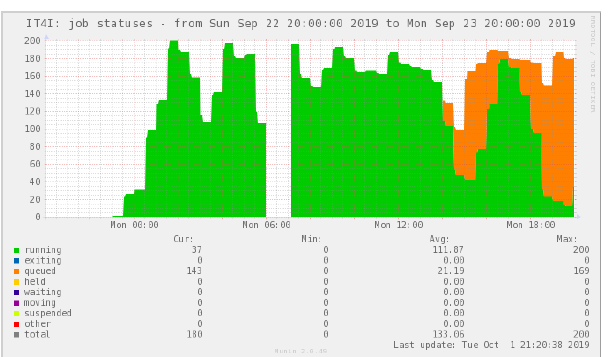
Figure 3. Statuses of jobs in the Salomon batch system (each bin is 5 minutes but values are updated every 30 minutes). The submission system is capable of filling all available resources (the limit is 200 jobs) within few hours.